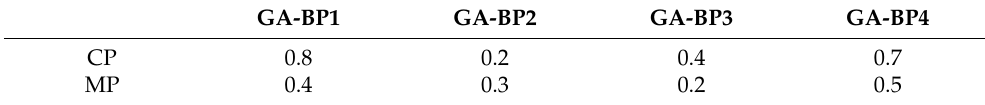
Table 10. Optimized CP and MP of different BP neural